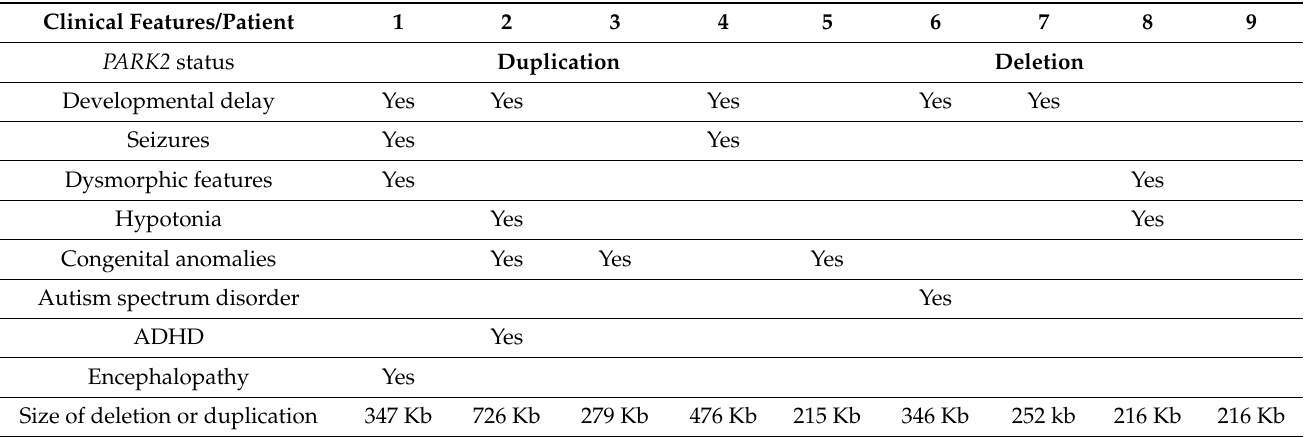
Table 2. Summary of the clinical findings, indications, and PARK2 gene status. Case 1–4 with duplication and case 5–9 with